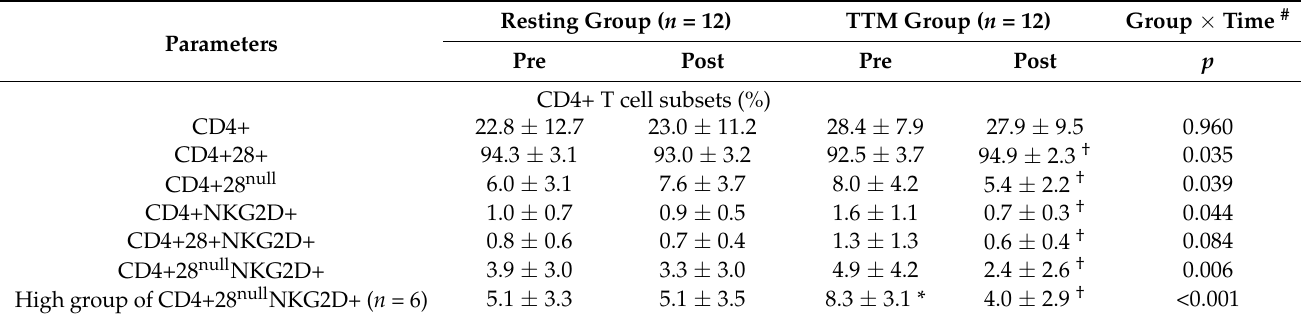
Table 2. Comparisons of the percentages of CD4+ T cell subsets between groups at pre (baseline) and post (multiple sessions; once weekly, 6 sessions), and intergroups.